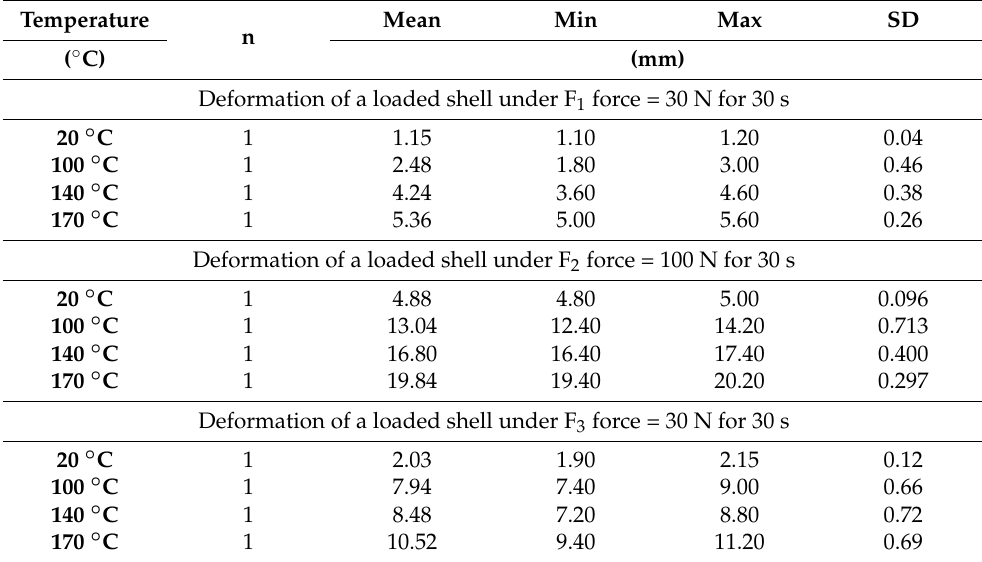
Table 5. Deformation of helmet shells under the influence of a mechanical load at different tempera- ture values.